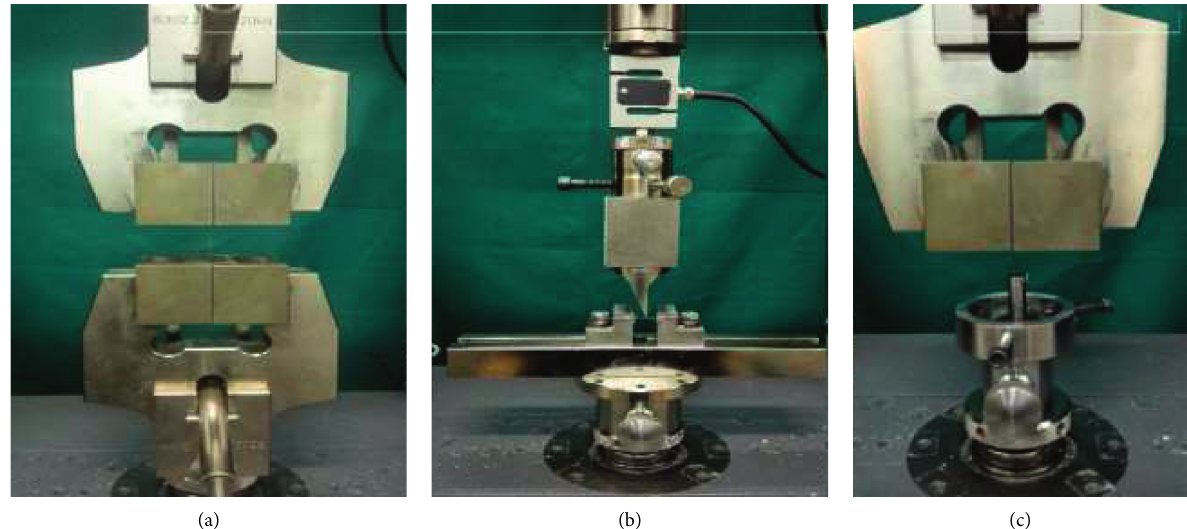
Figure 1: (a) Tensile strength, (b) three-point bending strength, and (c) friction forces of the wires were estimated using the universal testing